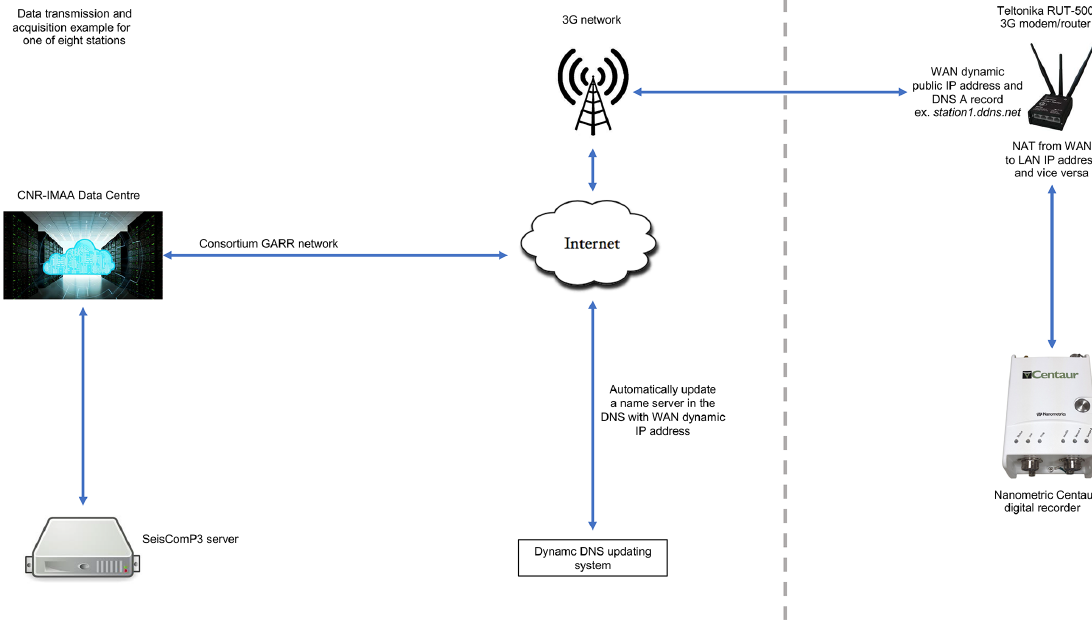
3 Acquired seismic